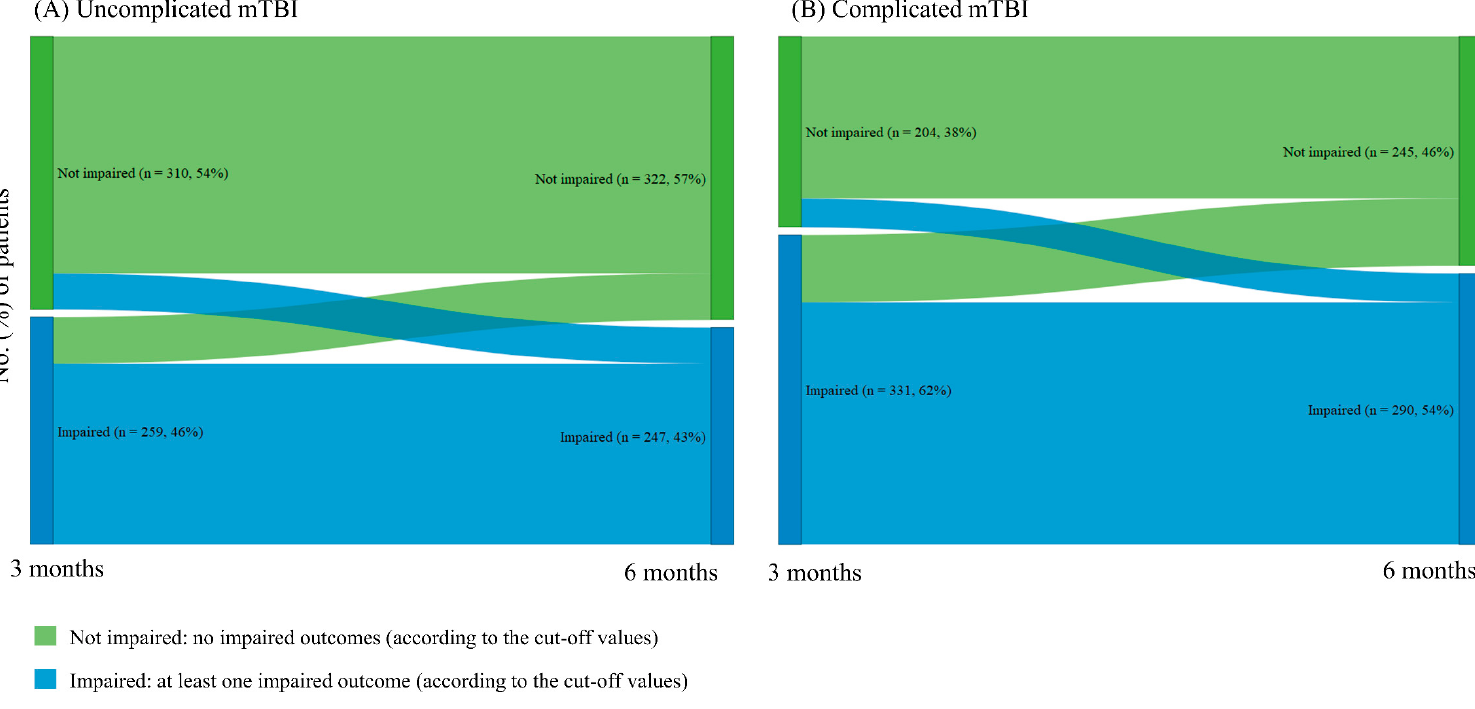
Figure A1. Development of impaired outcomes in individuals after uncomplicated and complicated mTBI at three and six months. 3